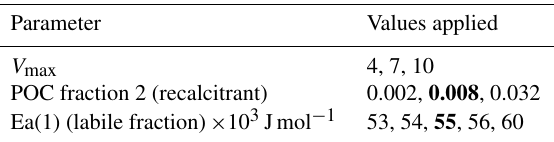
Table 3. Settings for parameters in TDEP (temperature-dependent). Values in bold are those applied in John et al. (2014) Parameter Values applied V max 4, 7, 10 POC fraction 2 (recalcitrant) 0.002, 0.008 ,